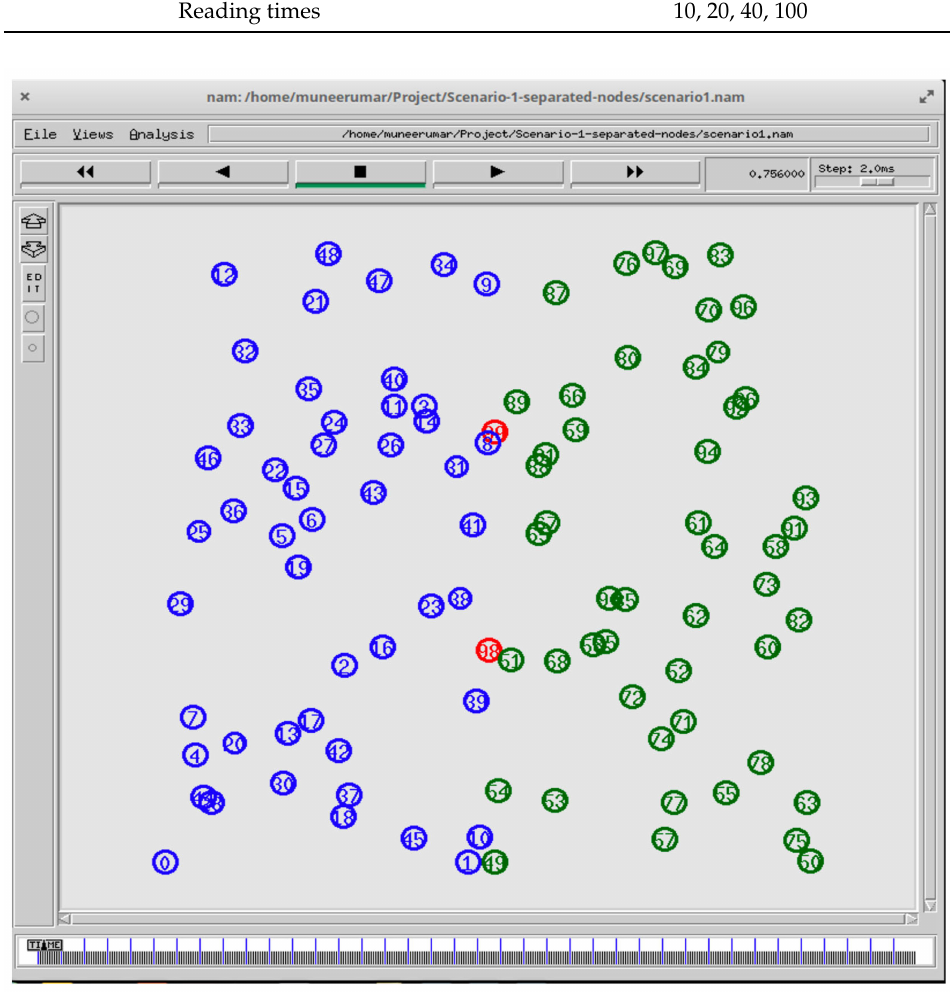
Figure 8. Case scenario 1: NS2 NetAnim